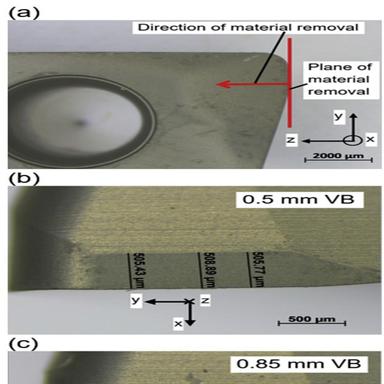
Micrographs of the cutting inserts: The location and direction of the material removal from the grinding process used to prepare "worn" inserts (a). The two different levels of flank wear on the inserts (b,c).